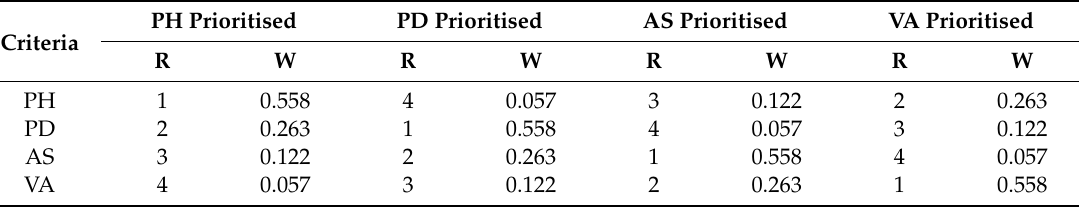
Table 2. “What if” weighting scenarios’